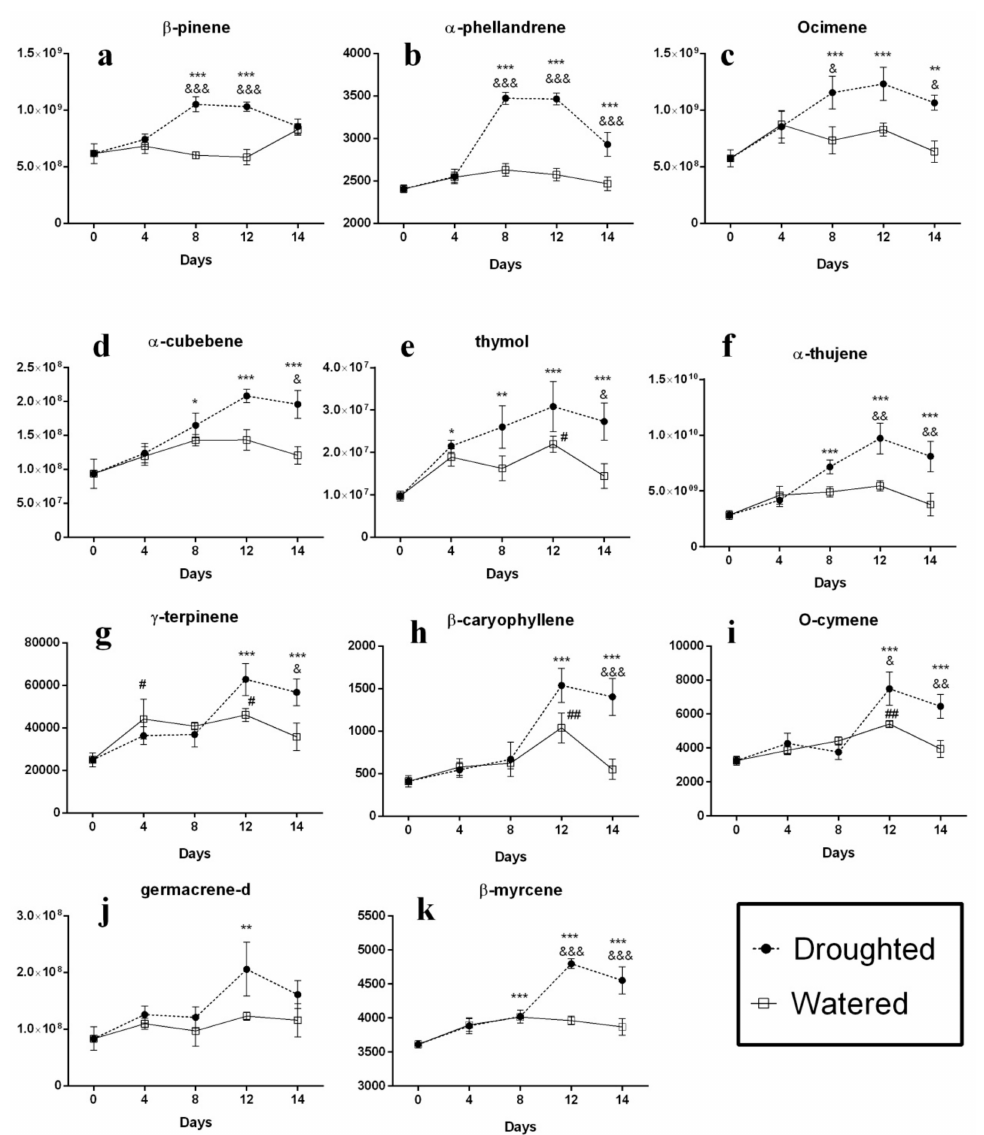
Figure 3. Profile of the changes of the volatile compounds in the leaves of the tolerant thyme plants during drought stress. Following water withholding, the leaves were harvested and analysis of non-polar extracts was carried out by direct infusion Fourier transform ion cyclotron resonance (DIFT-ICR) mass spectrometry. Vertical axis is the relative value of the compounds and horizontal axis the day of stress exposure. ( a ) β -pinene; ( b ) α -phellandrene; ( c ) ocimene; ( d ) α -cubebene; ( e ) thymolo; ( f ) α -thujene; ( g ) γ -terpinene; ( h ) β -caryophyllene; ( i ) O-cymene; ( j ) germacrene-d; ( k ) β -myrcene. * p < 0.05 vs. day 0 of Droughted group; ** p < 0.01 vs. day 0 of Droughted group, *** p < 0.001 vs. day 0 of Droughted group, ## p < 0.01 vs. day 0 of Watered group; ### p < 0.001 vs. day 0 of Watered group; & p < 0.05 Droughted vs. Watered group; && p < 0.01 Droughted vs. Watered group; &&& p < 0.001 Droughted vs. Watered group. Data are expressed as the mean ± S.E.M. Two-way ANOVA followed by the Sidak’s multiple comparisons test was